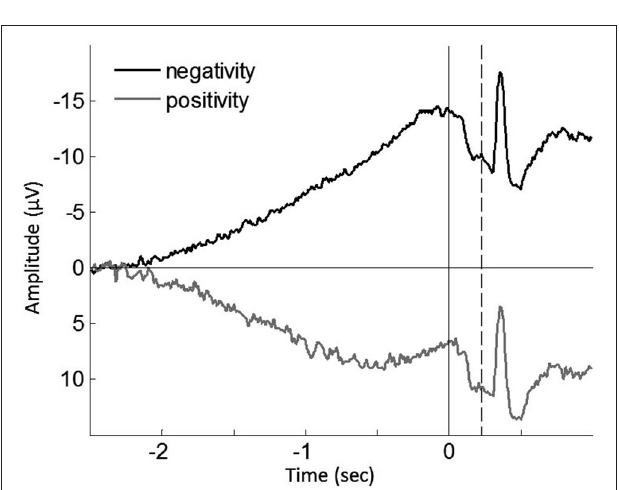
FIGURE 4 | Grand averaged ongoing negative potential (black trace) and positive potential (gray trace) during the operant-T task . Solid vertical line represents the onset of the finger movement, while dashed vertical line indicates the tone onset. The shift of perceived time of the tone towards action was increased in ongoing negativity ( p = 0.023; see the text). The grand mean of the proportion of positive epochs is 30.91% ± 2.0, which results in prolonged ongoing negativity in the early RP (see Figure 5